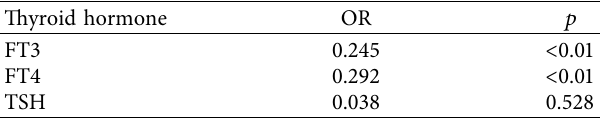
Table 4: Correlation analysis between HAMA and thyroid hor- mone in patients without thyroid disease by Pearson